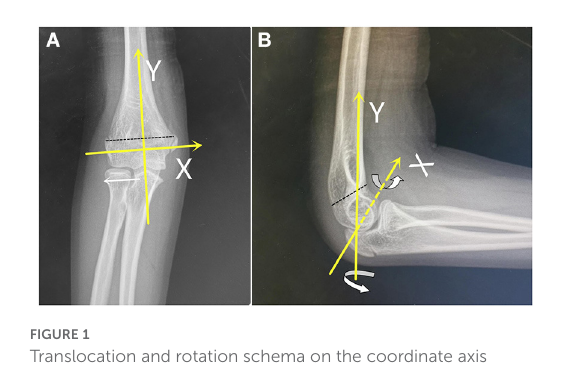
FIGURE1 Translocation and rotation schema on the coordinate axis (yellow line) on normal anteroposterior (AP) and lateral radiographs. The Y -axis is parallel to the humeral shaft, the X -axis is perpendicular to the Y -axis crossing both supracondylar, and the black dotted line indicates the fracture line. In (A) , the white arrow indicates lateral translocation; in (B) , the rotate arrows indicate the rotation along the X - or Y -axes of the distal fragment.